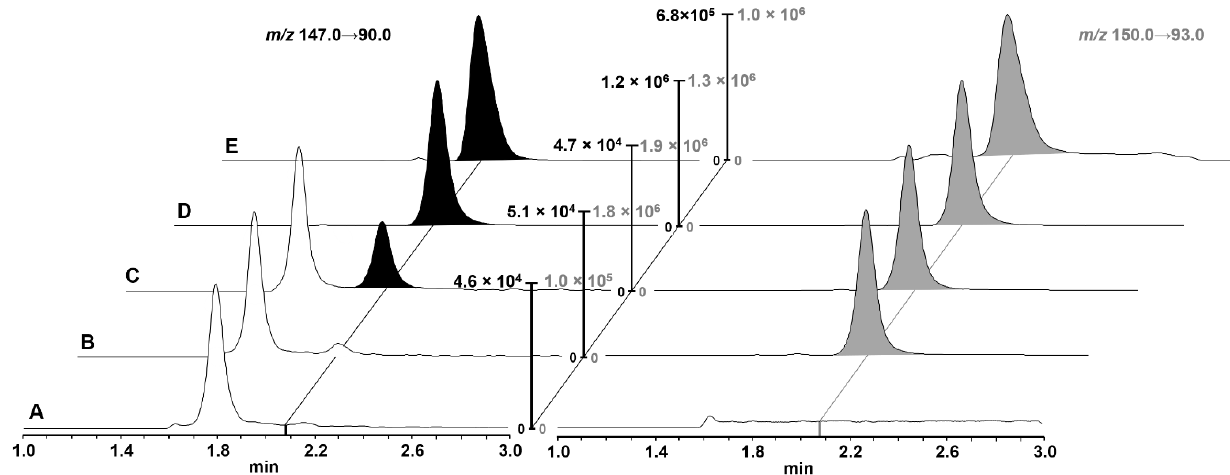
Figure 2. Representative UPLC-MS/MS chromatograms of Gly-Sar in cell lysates. Gly-Sar transition is shown on the left (black filling), and the IS transition is shown on the right (gray filling). Intensities were normalized to the highest signal in the current run: ( A ) blank sample; ( B ) blank lysate with added IS; ( C ) sample at LLOQ concentration; ( D ) sample at mid QC concentration; ( E ) intracellular Gly-Sar concentration after incubation with 20 µ M Gly-Sar and 1 mM losartan for 10 min (quantified Gly-Sar concentration: 23.9